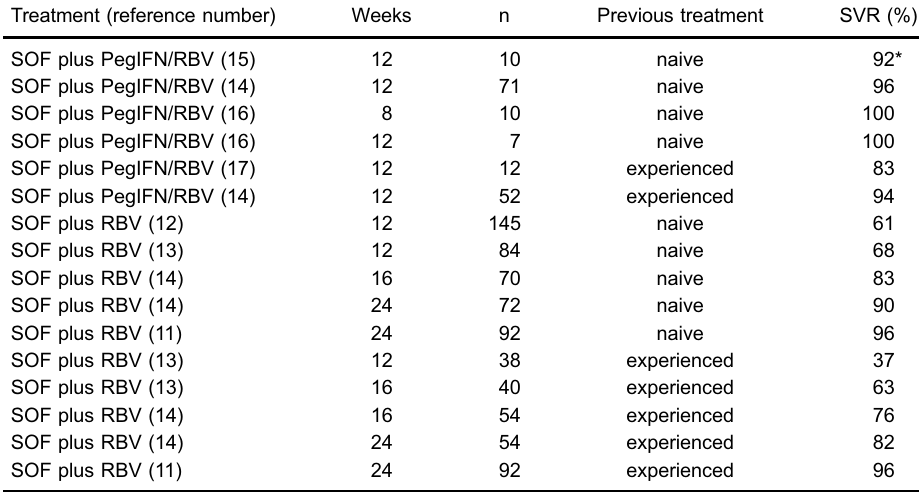
Table 1. Summary of sustained virological response (SVR) rates in non-cirrhotic patients with hepatitis C virus (HCV) genotype 3 infection treated with sofosbuvir (SOF) plus pegylated interferon (PegIFN)/ribavirin (RBV) or SOF plus